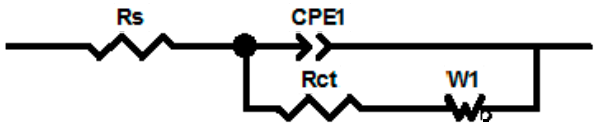
Figure 12. Model equivalent circuit of the GCE/PDMA-MWCNT immunosensor.